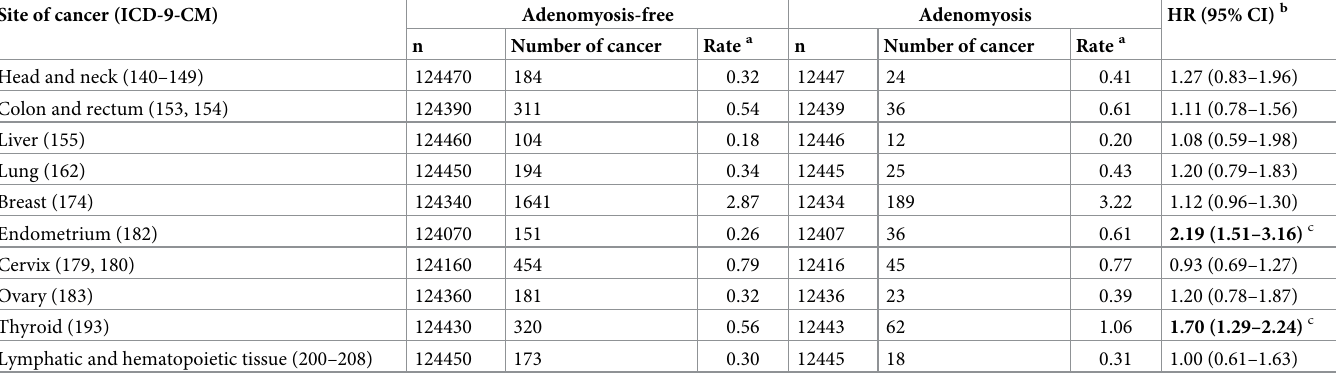
Table 3. Comparison of distribution of cancer-free survival (CFS) between adenomyosis and adenomyosis-free cohorts. Site of cancer